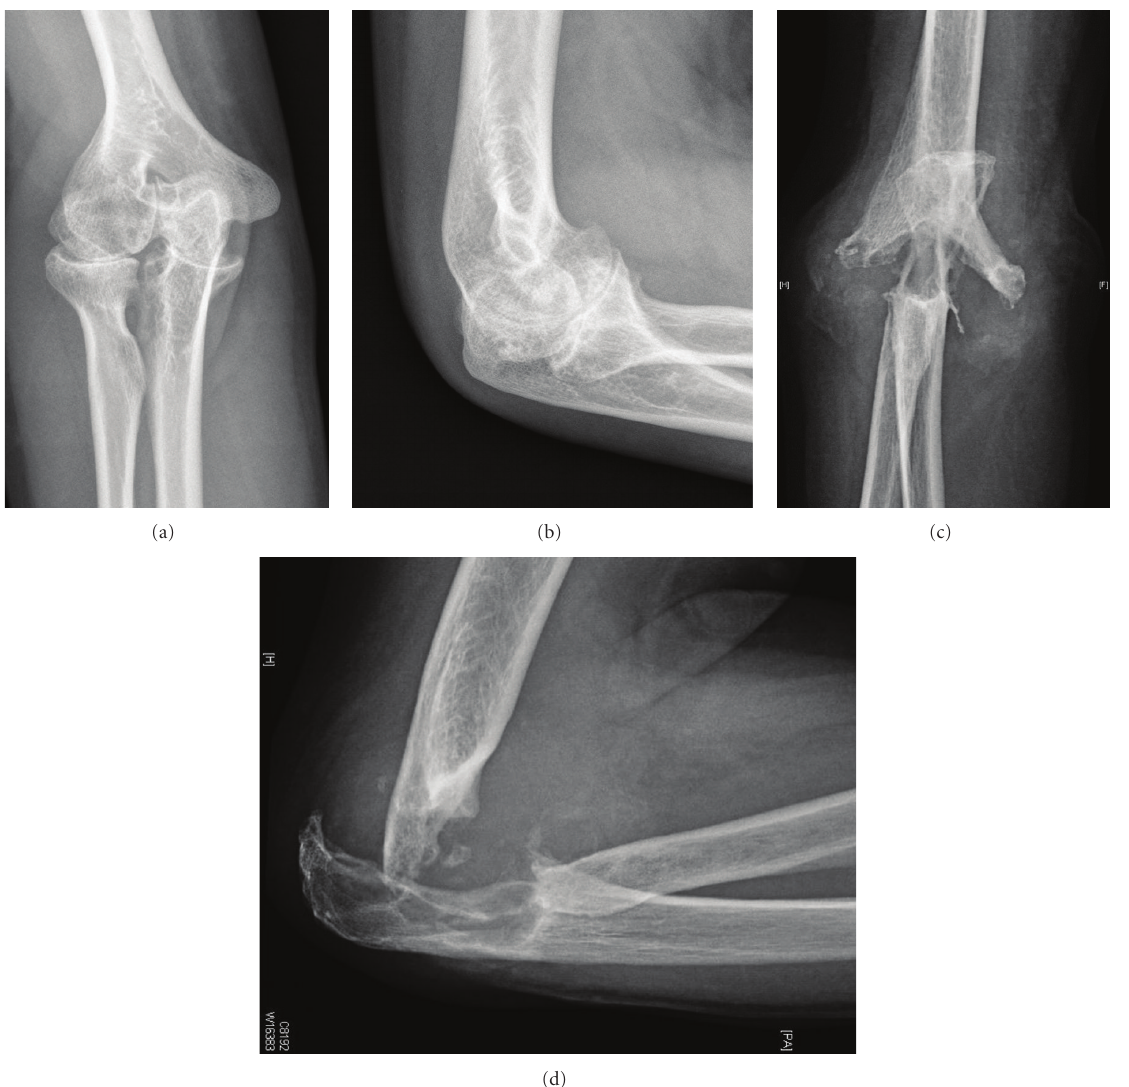
Figure 2: Hemophilic arthropathy of the elbow. At the age of 29 a severe degree of arthropathy was already seen in the AP radiograph (a) and in the lateral view (b). Forty years later the joint was fully destroyed both in the AP view (c) as in the lateral radiograph